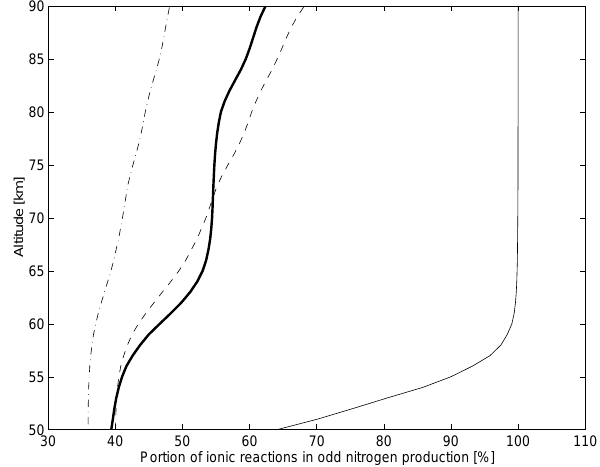
Fig. 4. The portion of ions in N( 4 S), N( 2 D), NO and total odd nitrogen production represented by dash-dot, dashed, solid and bold solid lines, respectively. These curves are for the 23 October 1989. The contribution of secondary electrons is not taken into account.